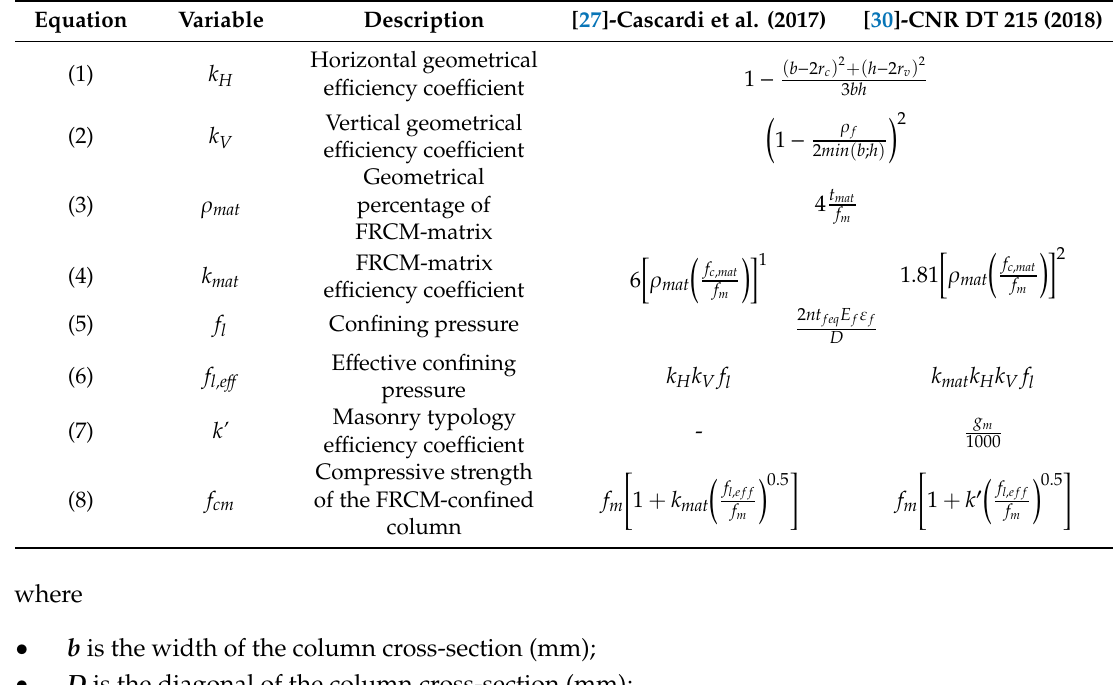
Table 3. Description of the analytical